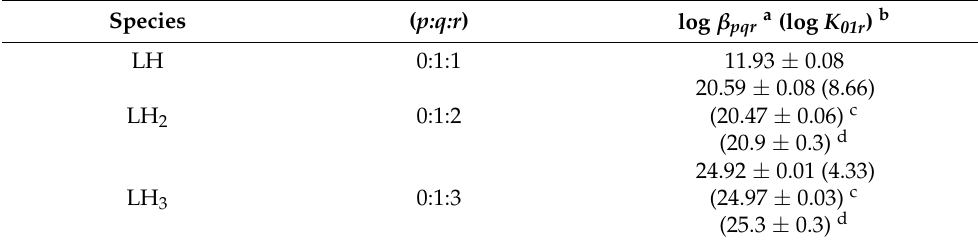
Table 3. Protonation constants a of CFA in KCl (aq) at I = 0.2 mol · dm − 3 and T = 298.15 K. Species